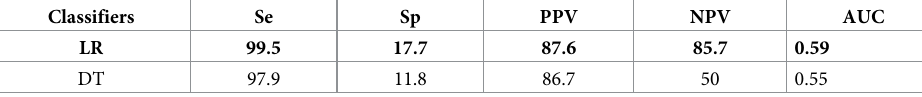
Table 5. Performance assessment (in %) of parameters for two ML-based